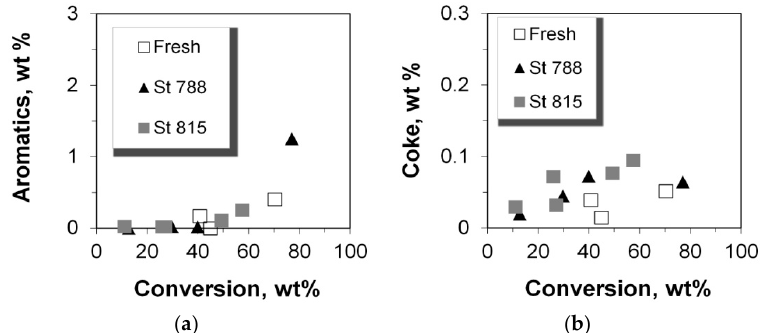
Figure 16. Product yields of: ( a ) aromatics and ( b ) coke versus the conversion of n-C 12 .